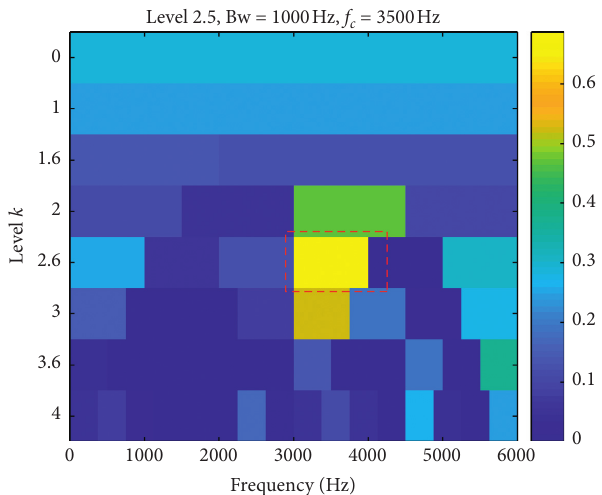
Figure 7: The colormap of the simulation signal via fast kurtogram.